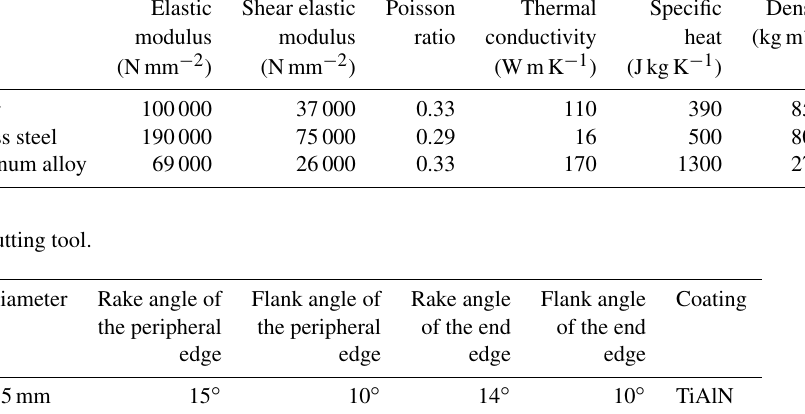
Table 1. Properties of the workpiece material. Material